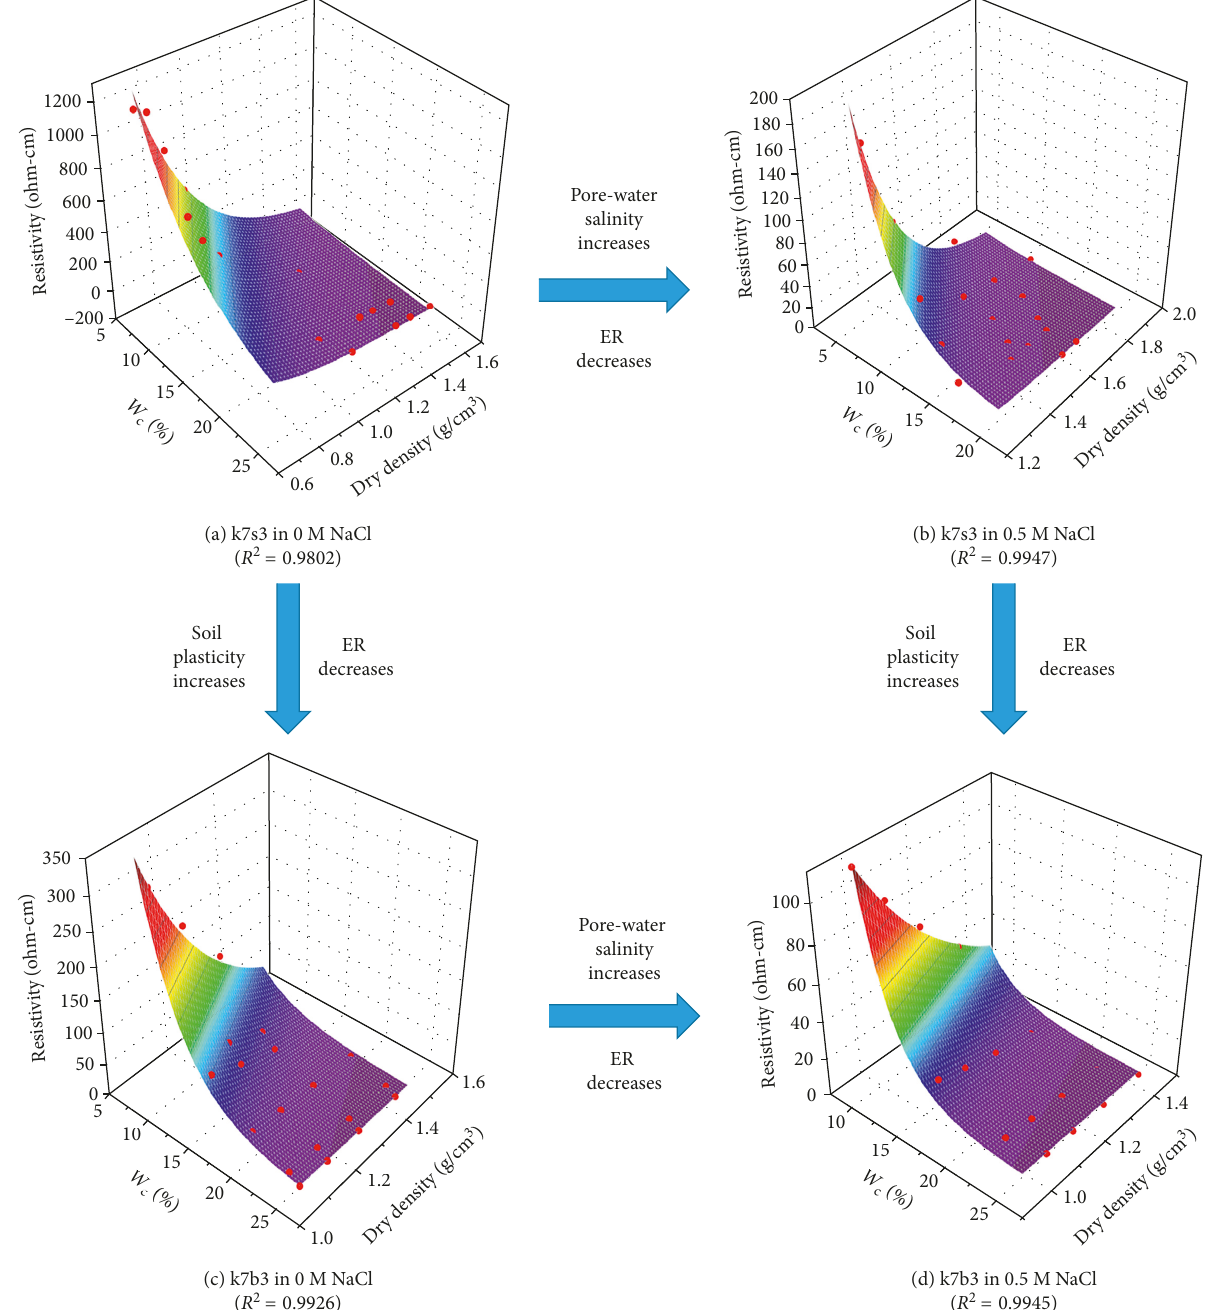
Figure 6: Examples of 3D plots for resistivity (Ohm-cm), water content ( W